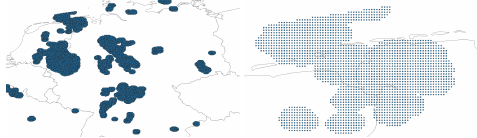
Figure 2. Zoomed-in examples of rain data in QuadTile format for Germany (left) and East Frisia